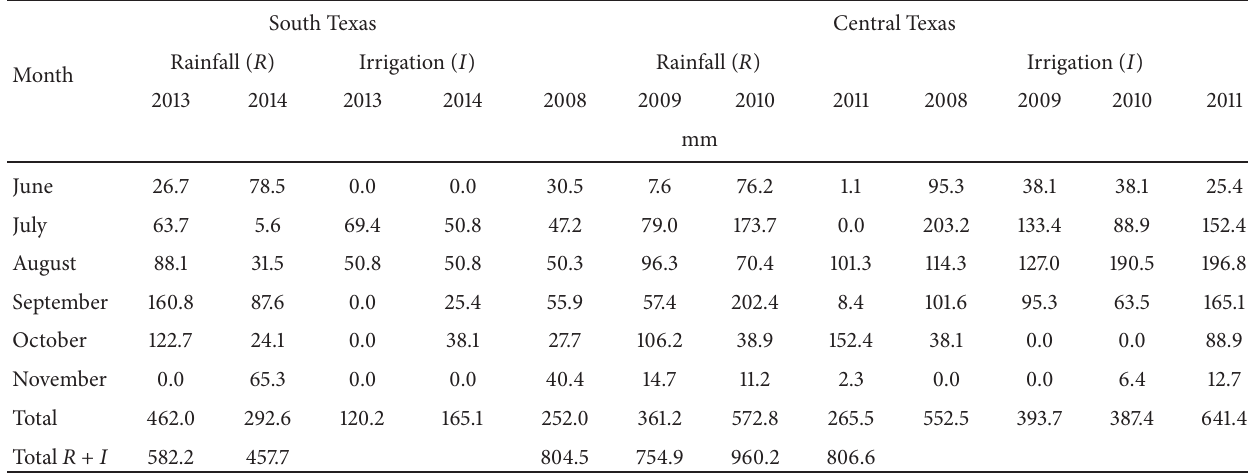
Table 1: Rainfall and irrigation for each year of the